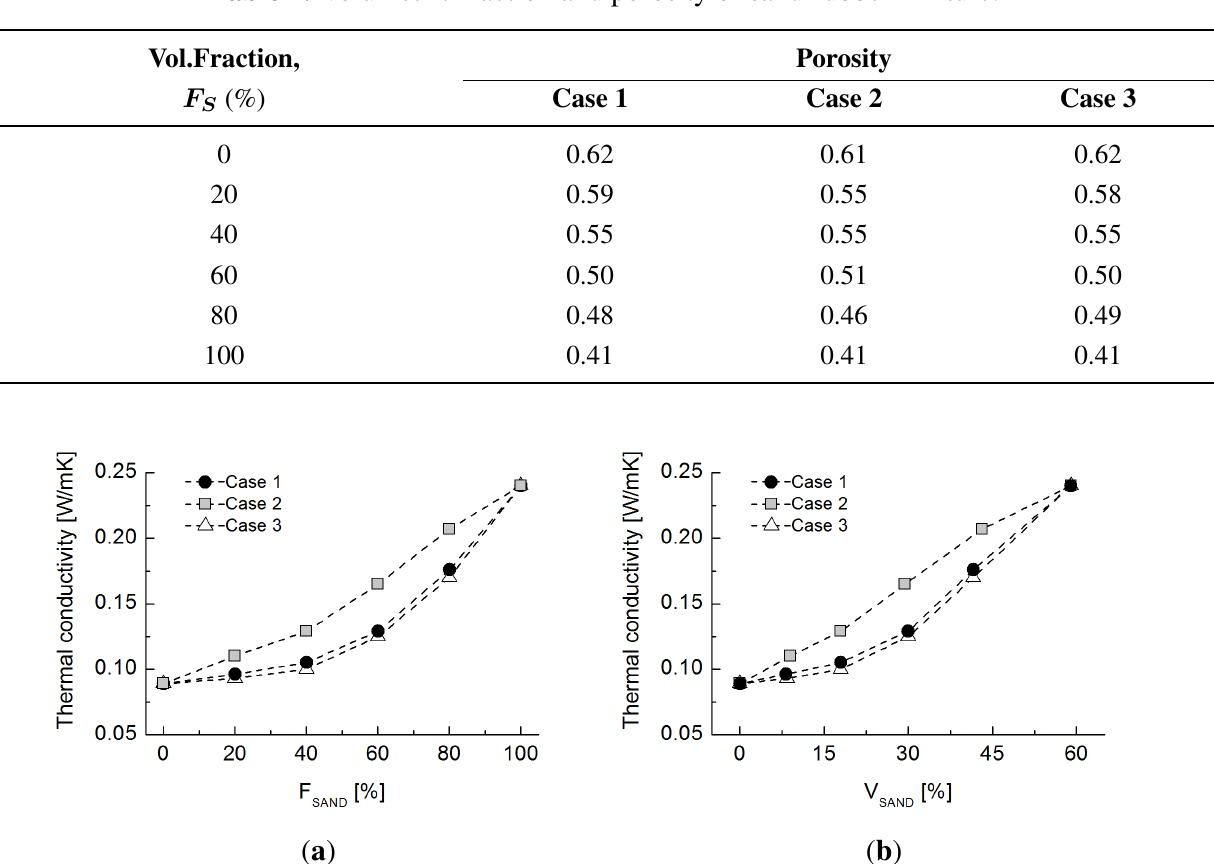
Table 4. Volumetric fraction and porosity of sand-rubber mixture.